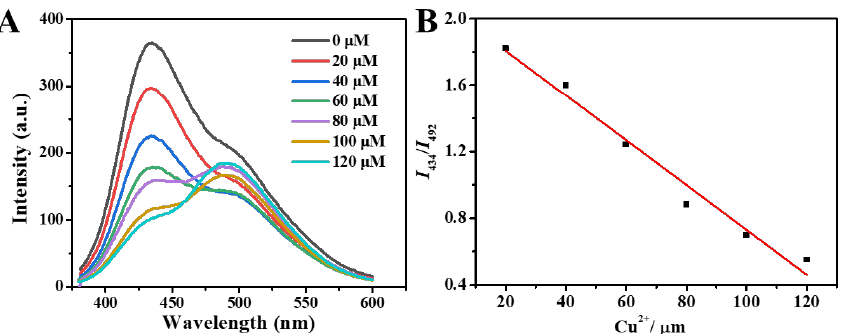
Figure 6. ( A ) Fluorescence emission spectra of 7–CDs at different Cu 2+ concentrations, ( B ) Cu 2+ titration curve of the chemosensor for emission ratio at 434 and 492 nm ( I 434 / I 492 ). Indicated values are means of three measurements with the standard error of less than 3%.